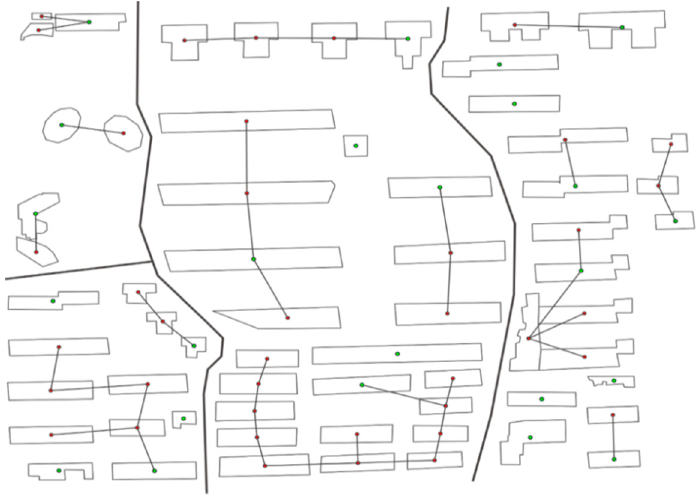
Figure 11. Minimum support tree (MST).